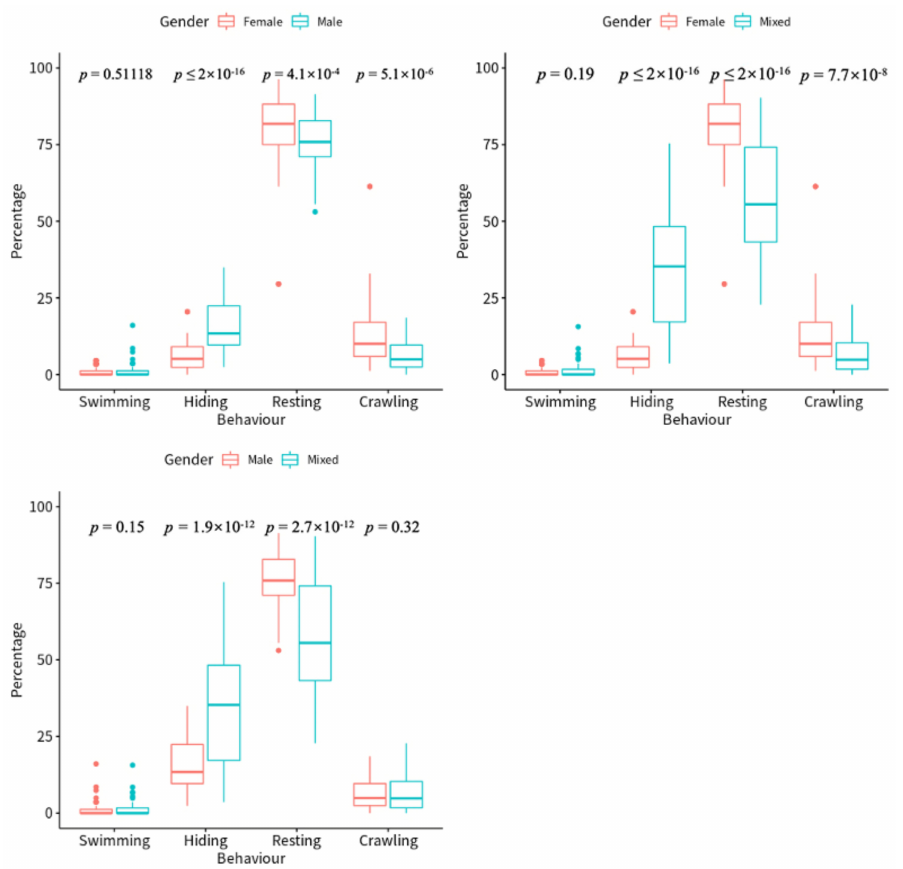
Figure 2. The differences in the proportion of crawling, hiding, swimming, and resting behavior of P. japonicus among all-female, all-male, and mixed